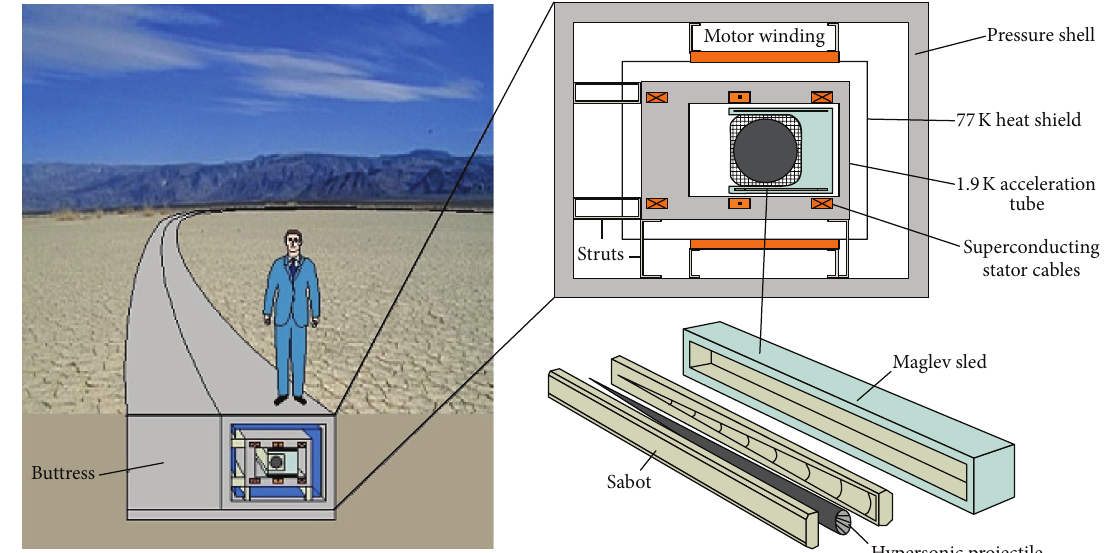
Figure 18: SCS launch